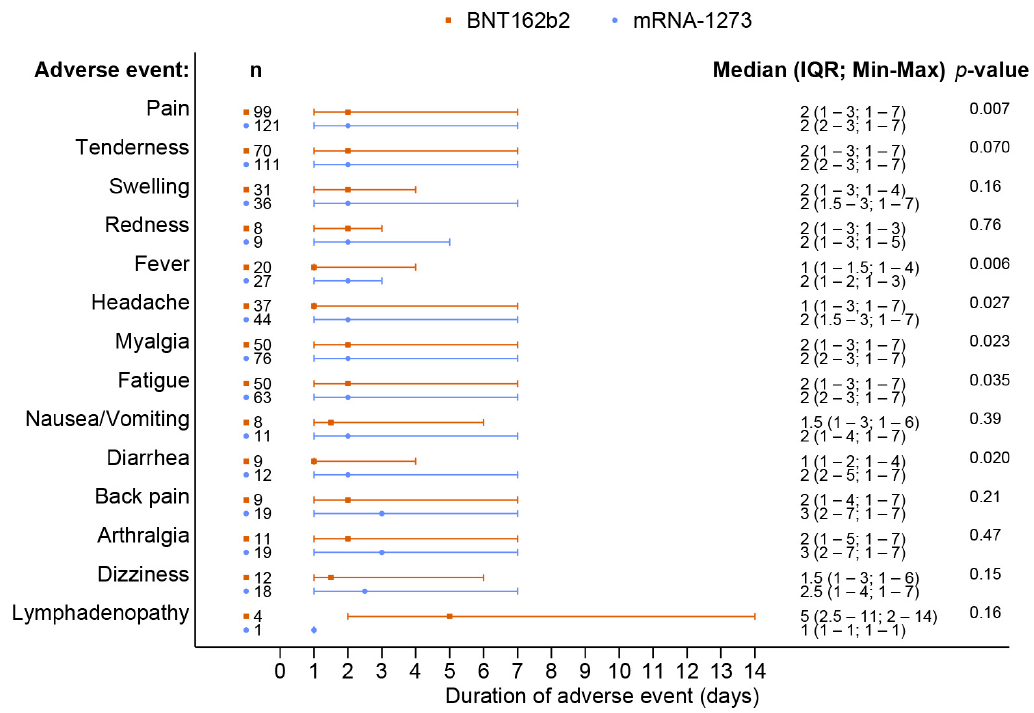
Figure 3. Duration of adverse events following the booster dose with the BNT162b2 as compared to the mRNA-1273 vaccine. Results from the univariate logistic regression analysis revealed significant factors associated with any adverse events, including age, sex, concurrent steroid use, and type of primary vaccine (Table 3). We incorporated these factors into the multivariate regres- sion analysis to evaluate the association between the type of mRNA vaccine and vaccine reactogenicity. While controlling for significant independent factors, we found that the booster dose with the BNT162b2 or mRNA-1273 vaccines resulted in a similar risk of de- veloping any adverse events (BNT162b2 vs. mRNA-1273; OR 1.22; 95% CI, 0.78–1.92; p = 0.38). We also investigated this association in relation to local and systemic reactions, and there was no correlation between the type of booster mRNA vaccine and vaccine reac- togenicity (Tables 4 and 5).